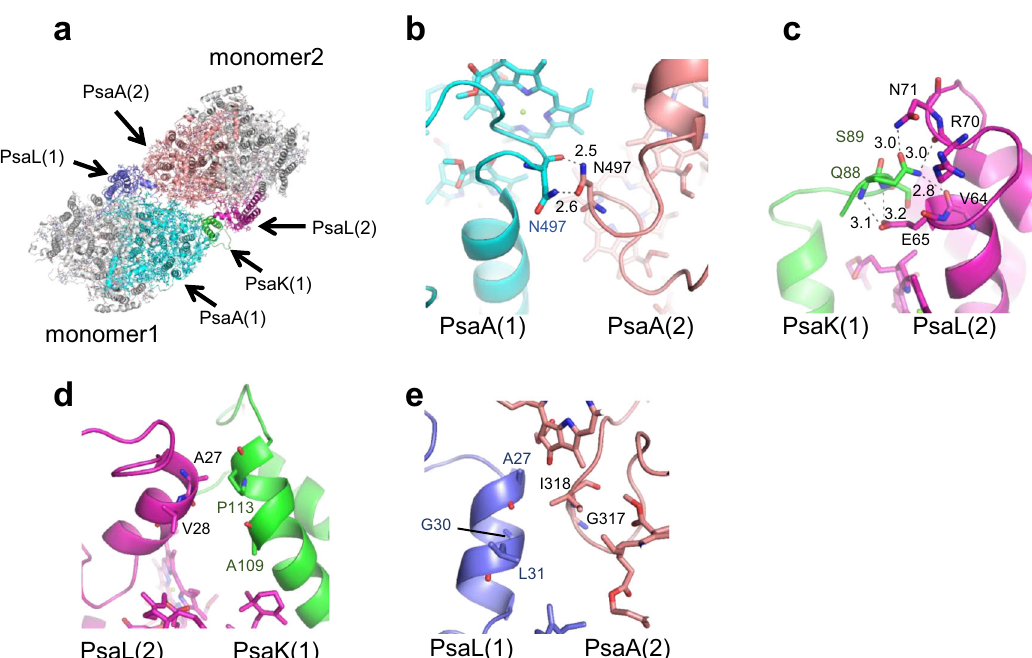
Fig. 3 Intermonomer interactions between monomer1 and monomer2. a Structure of a monomer1/2 dimer unit from the PSI tetramer viewed along the membrane normal from the stromal side. b Interactions between monomer1-PsaA and monomer2-PsaA at the lumenal side. c , d Interactions between monomer1-PsaK and monomer2-PsaL at the lumenal ( c ) and stromal ( d ) sides. e Interactions between monomer1-PsaL and monomer2-PsaA at the stromal side.